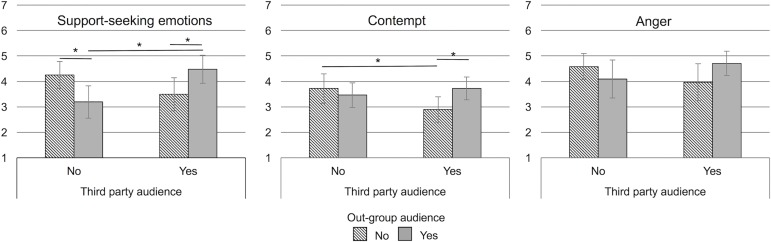
Support-seeking emotions, contempt, and, anger as experienced and expressed towards different audiences in Study 1.Error bars depict 95% confidence intervals. * p < .05.